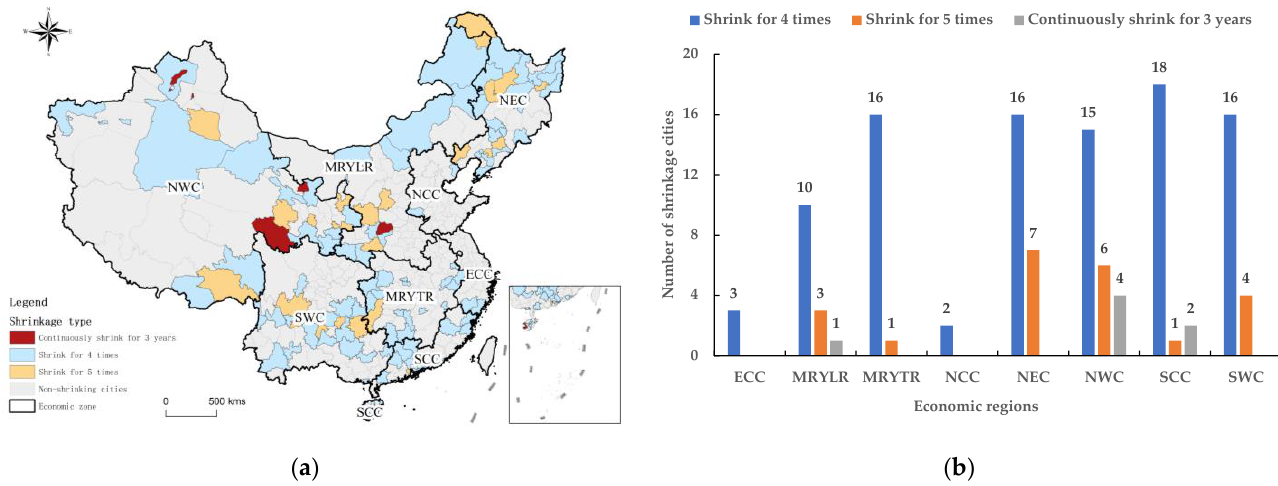
Figure 3. ( a ) The spatial distribution of shrinking cities in China, 2012 – 2020; ( b ) types of shrinking cities in China.